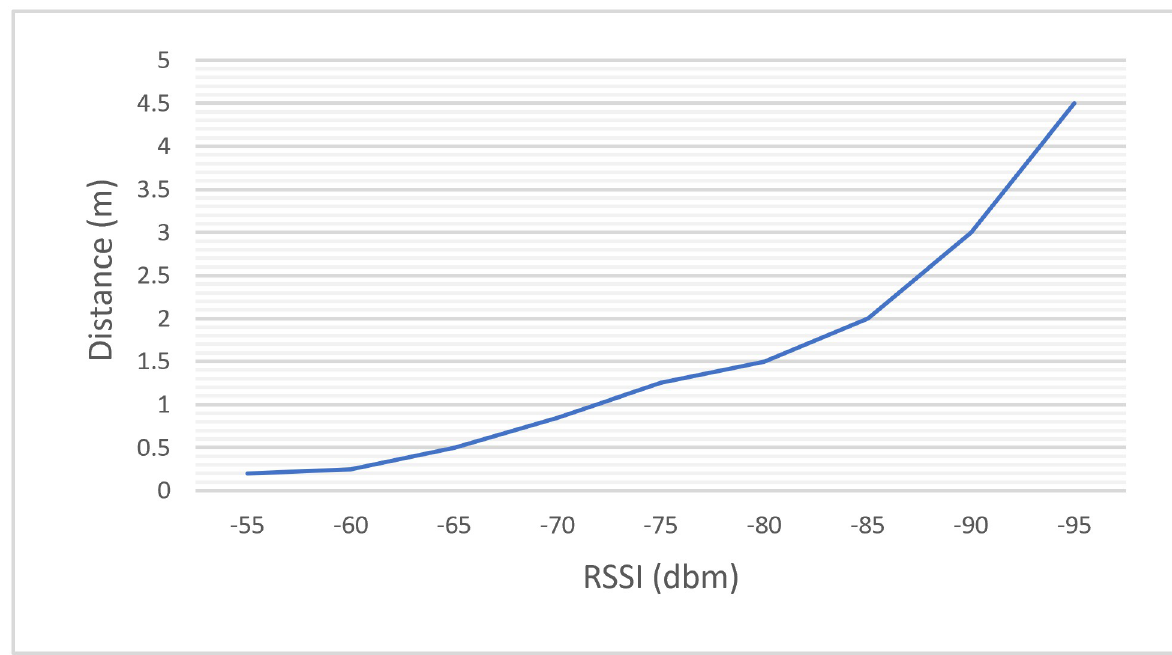
Fig 10. The received signal strength indication (RSSI) values of Bluetooth Low Energy (BLE) tags with their distances.